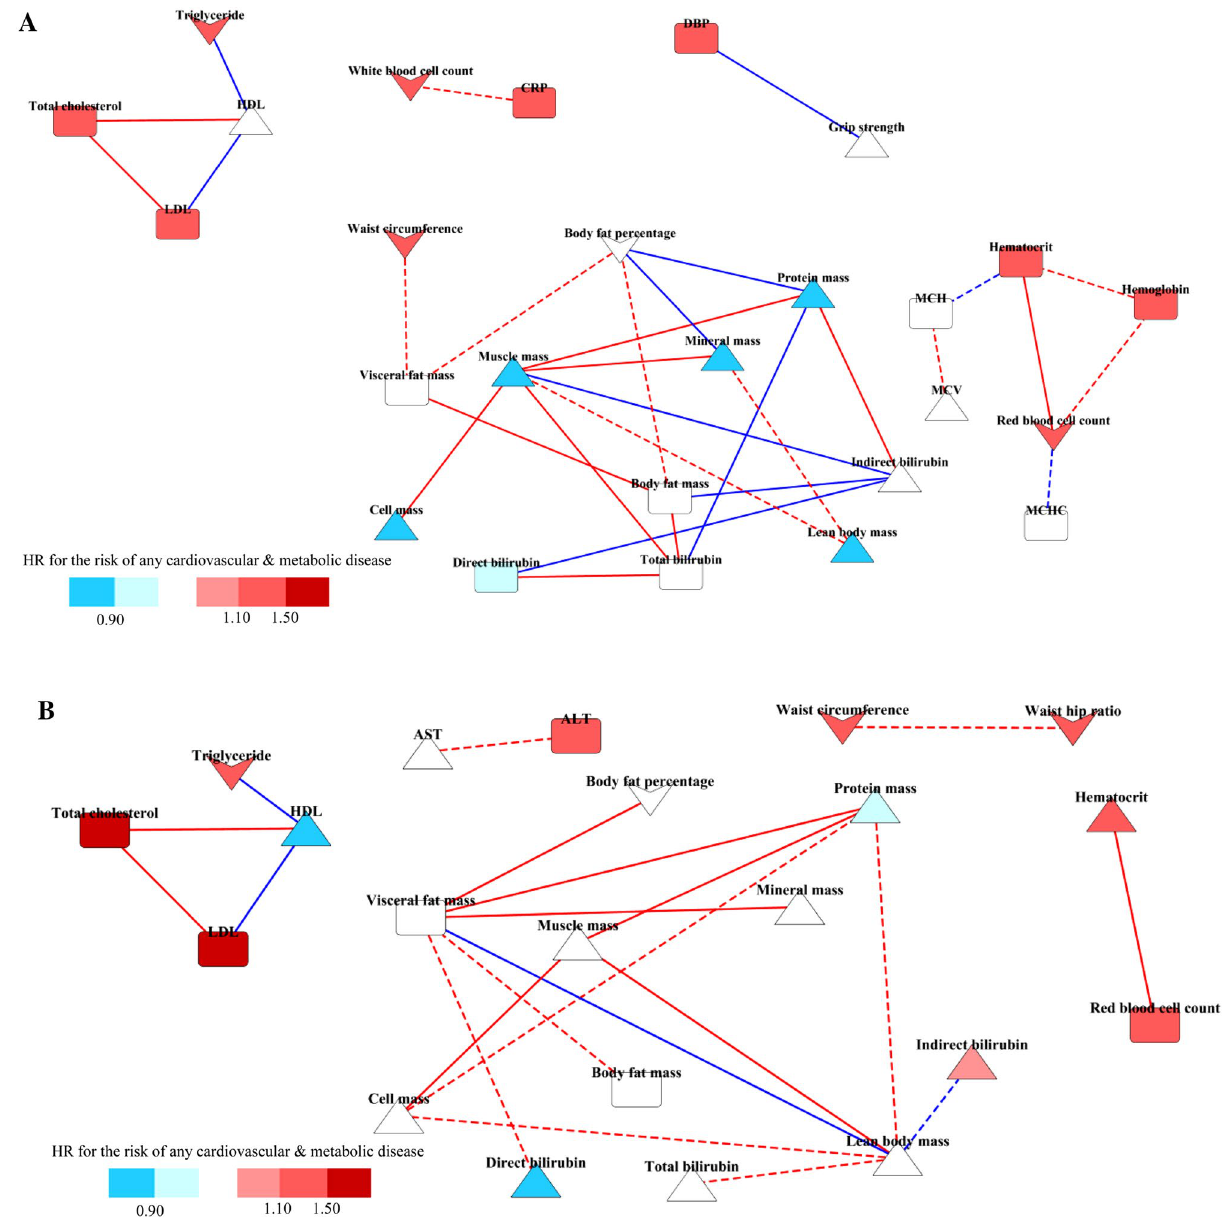
Figure 2. Networks of biomarkers showing their associations with regular exercise and risk of one or more diseases. Networks were constructed based on the differential correlations between partial correlation coefficients of the exercise and non-exercise groups adjusted for age. Twenty-six nodes and 31 edges in men ( A ) and 21 nodes and 21 edges in women ( B ). Δ: positive associations with regular exercise, ∀ : negative associations with regular exercise, red nodes: positive associations with the risks of one or more chronic diseases, blue nodes: negative associations with the risks of one or more chronic diseases. Solid edges: higher correlations in the exercise group, dotted edges: higher correlations in the non-exercise group, red edges: positive correlations, blue edges: negative correlations. Networks were visualized by Cytoscape software (ver.3.7.2). DBP, diastolic blood pressure; HDL, high density lipoprotein-cholesterol; LDL, low density lipoprotein-cholesterol; AST, aspartate aminotransferase; ALT, alanine aminotransferase; MCV, mean corpuscular volume; MCH, mean corpuscular hemoglobin; MCHC, mean corpuscular hemoglobin concentration; CRP, C-reactive